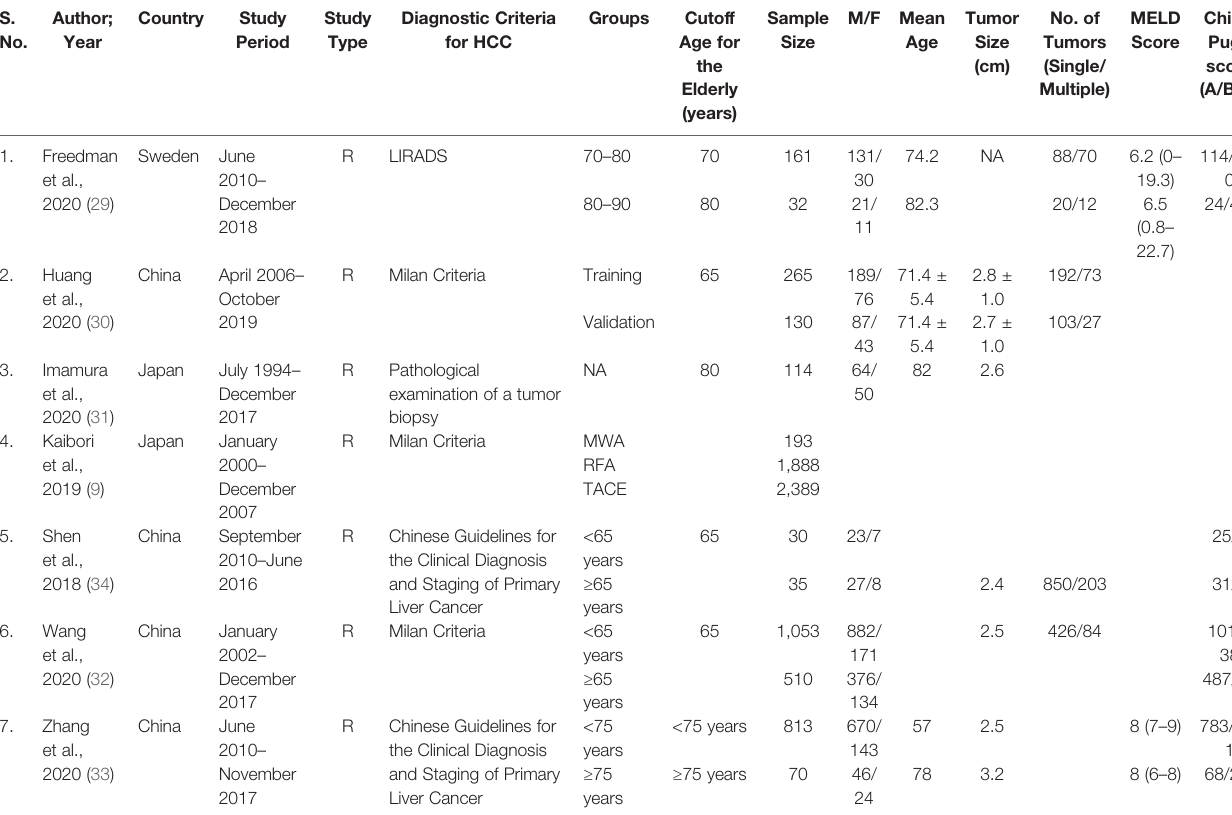
TABLE 1 | Baseline characteristics of included studies in the systematic review investigating microwave ablation for hepatocellular carcinoma in elderly patients. S.